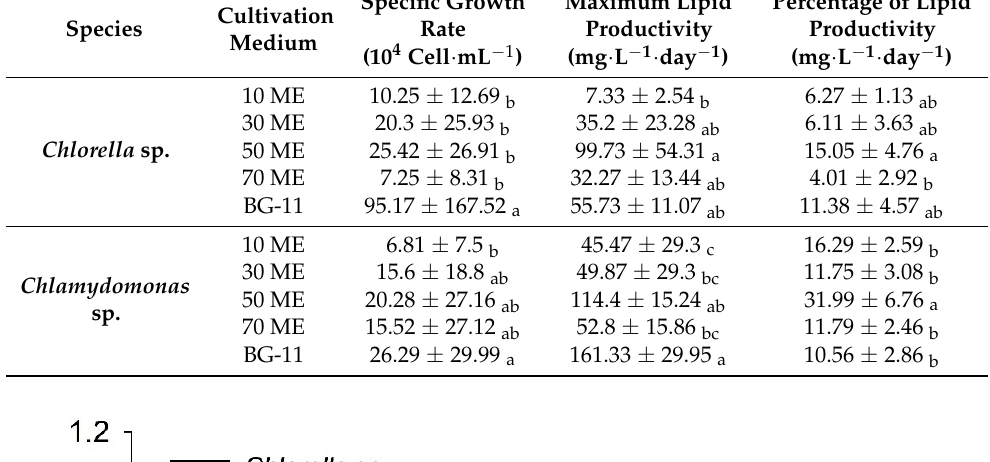
Table 2. Algae specific growth rate, maximum lipid productivity, and percentage of lipid productivity rate under different concentrations of malting effluent and a control medium (BG-11). Values are represented in mean SD. The statistics were derived from a one-way ANOVA with post hoc Tukey test. Different letters (a, b, c, ab or bc) in subscript indicate the significant differences ( p < 0.05) among different treatments.